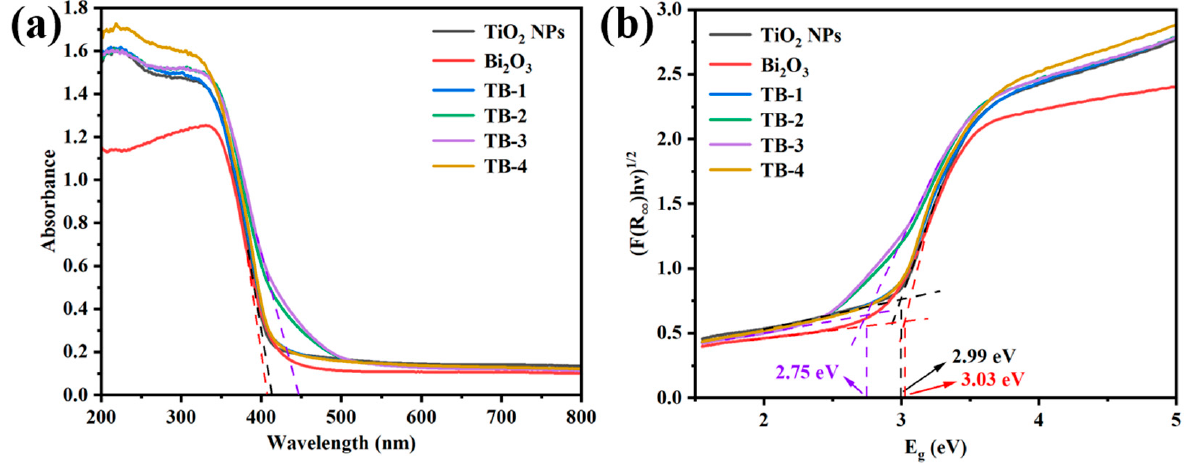
Figure 6. ( a ) UV–Vis DRS and ( b ) Tauc plots of TiO 2 NPs, Bi 2 O 3 , and TB-x (x =